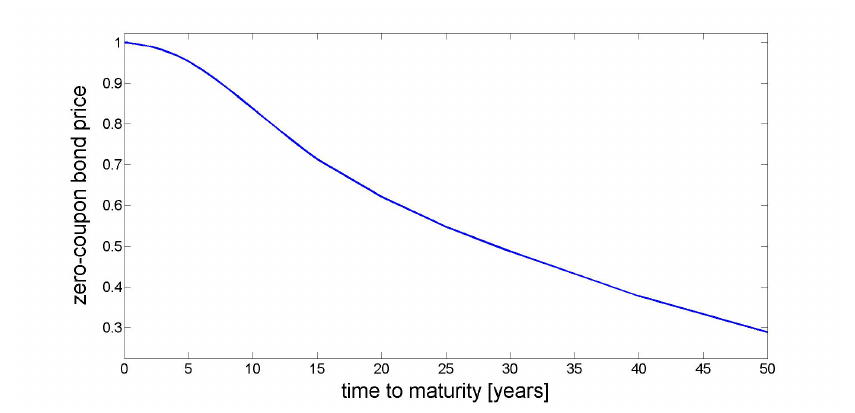
Figure 3. Discount Curve on 16 January